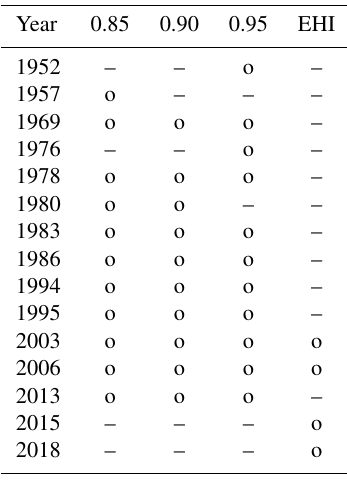
Table 8. As in Table 3 but for heatwaves in the GE region during the SHY.